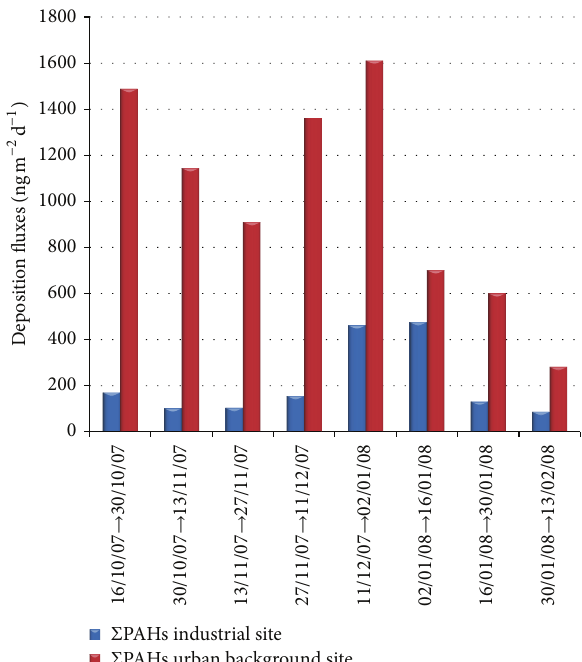
Figure 2: Sum of the PAHs detected (∑ PAHs ) in ng m −2 d −1 at two monitored